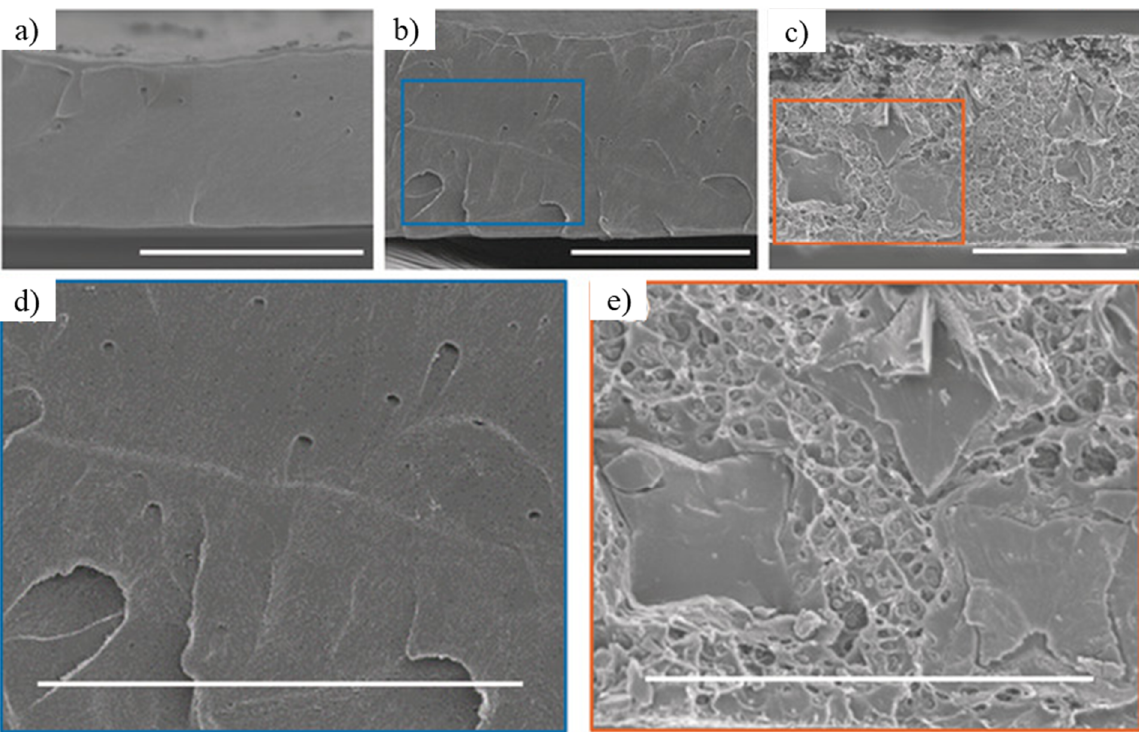
Figure 7. SEM image of a molecularly mixed matrix membrane, that shows CC3–R crystals within the Matrimid matrix [92]. ( a ) Pristine polymer Matrimid ( b ) 10 wt % porous organic cage (POC), ( c ) 20 wt % POC, ( d , e ) magnified image. Reproduced with permission from [93]. Copyright 2019 Angewandte Chemie International Edition.